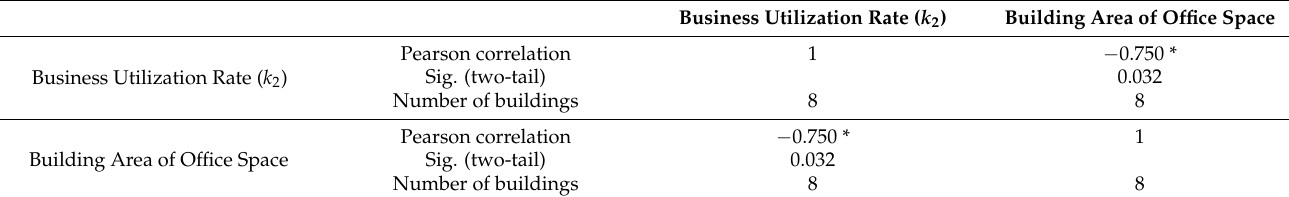
Table 8. Correlation between business indicators and the business utilization rate k 2 .